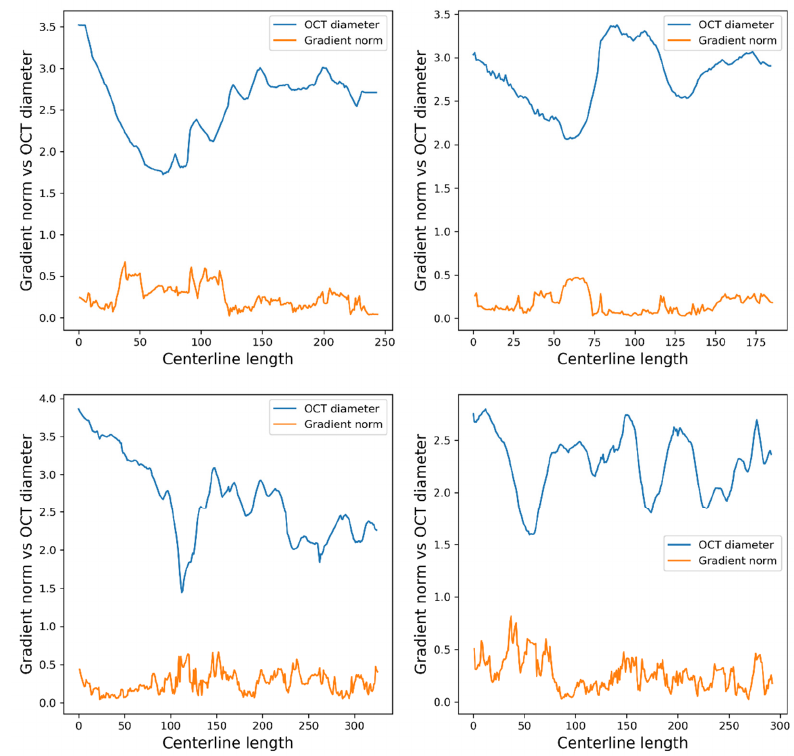
Figure 5. The saliency map that was computed for the ensemble CNN-FSL model. The saliency maps on the top correspond to samples with an invasive FFR > 0.8, and the saliency maps on the bottom correspond to samples with an invasive FFR < 0.8.